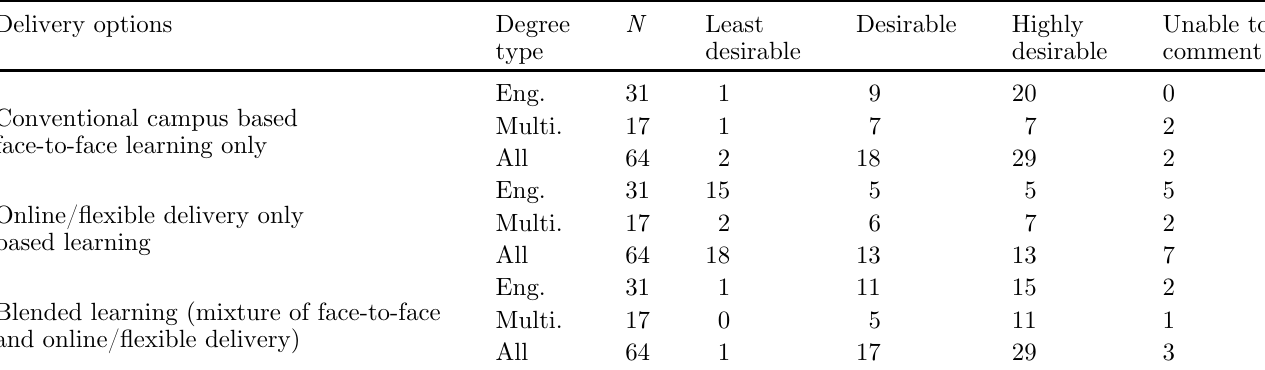
Table 4. Graduates ratings of the desirability of the currently available delivery options for tertiary level SE courses. Delivery